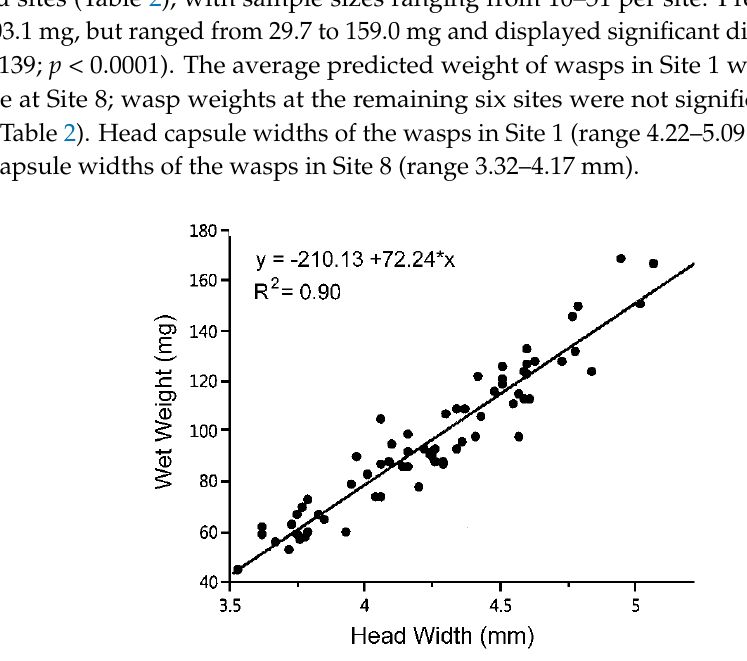
Figure 1. A linear relationship between head width and body mass (wet weight) in Cerceris fumipennis ( P < 0.001) at one North Carolina site.